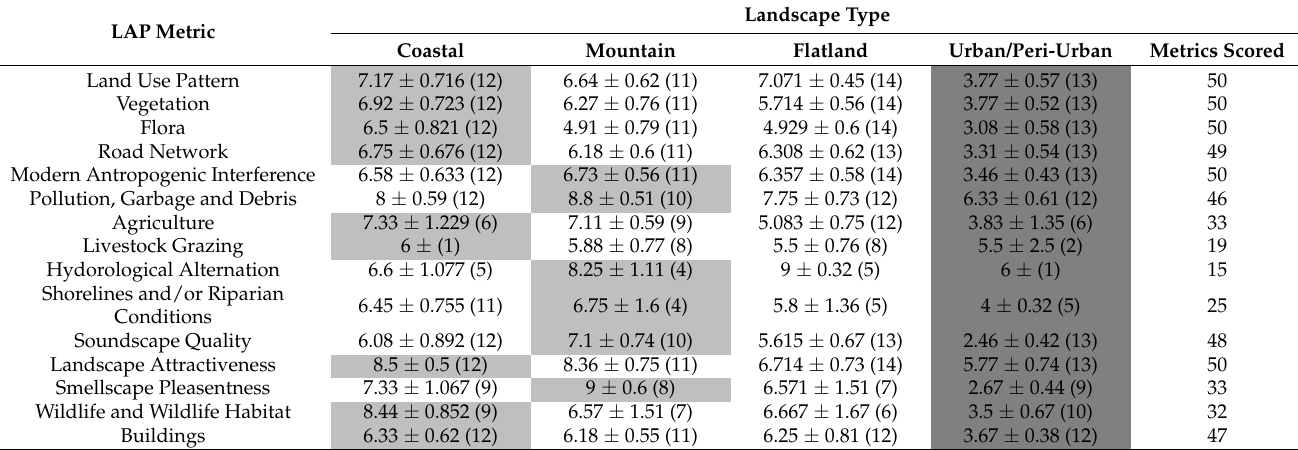
Table 2. Metric mean score ± standard error (number of cases scored in parentheses) per each metric. The shaded have highest (lighter shade) and lowest (darker shade) values. Note that in some landscape views, the assessors chose not to score certain metrics, either because they were not perceivable or the assessor did not have enough evidence to score effectively; this is given in the last column.